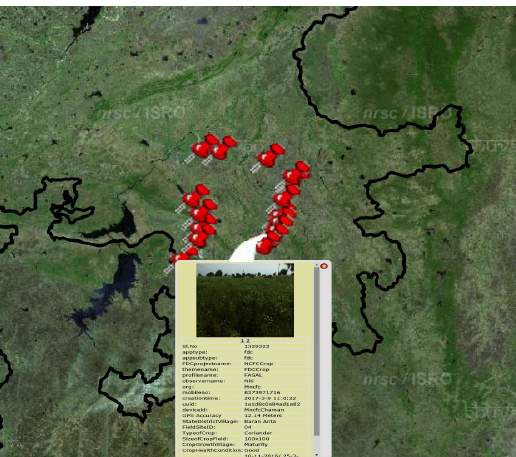
Figure 3. Ground Truth on Bhuvan